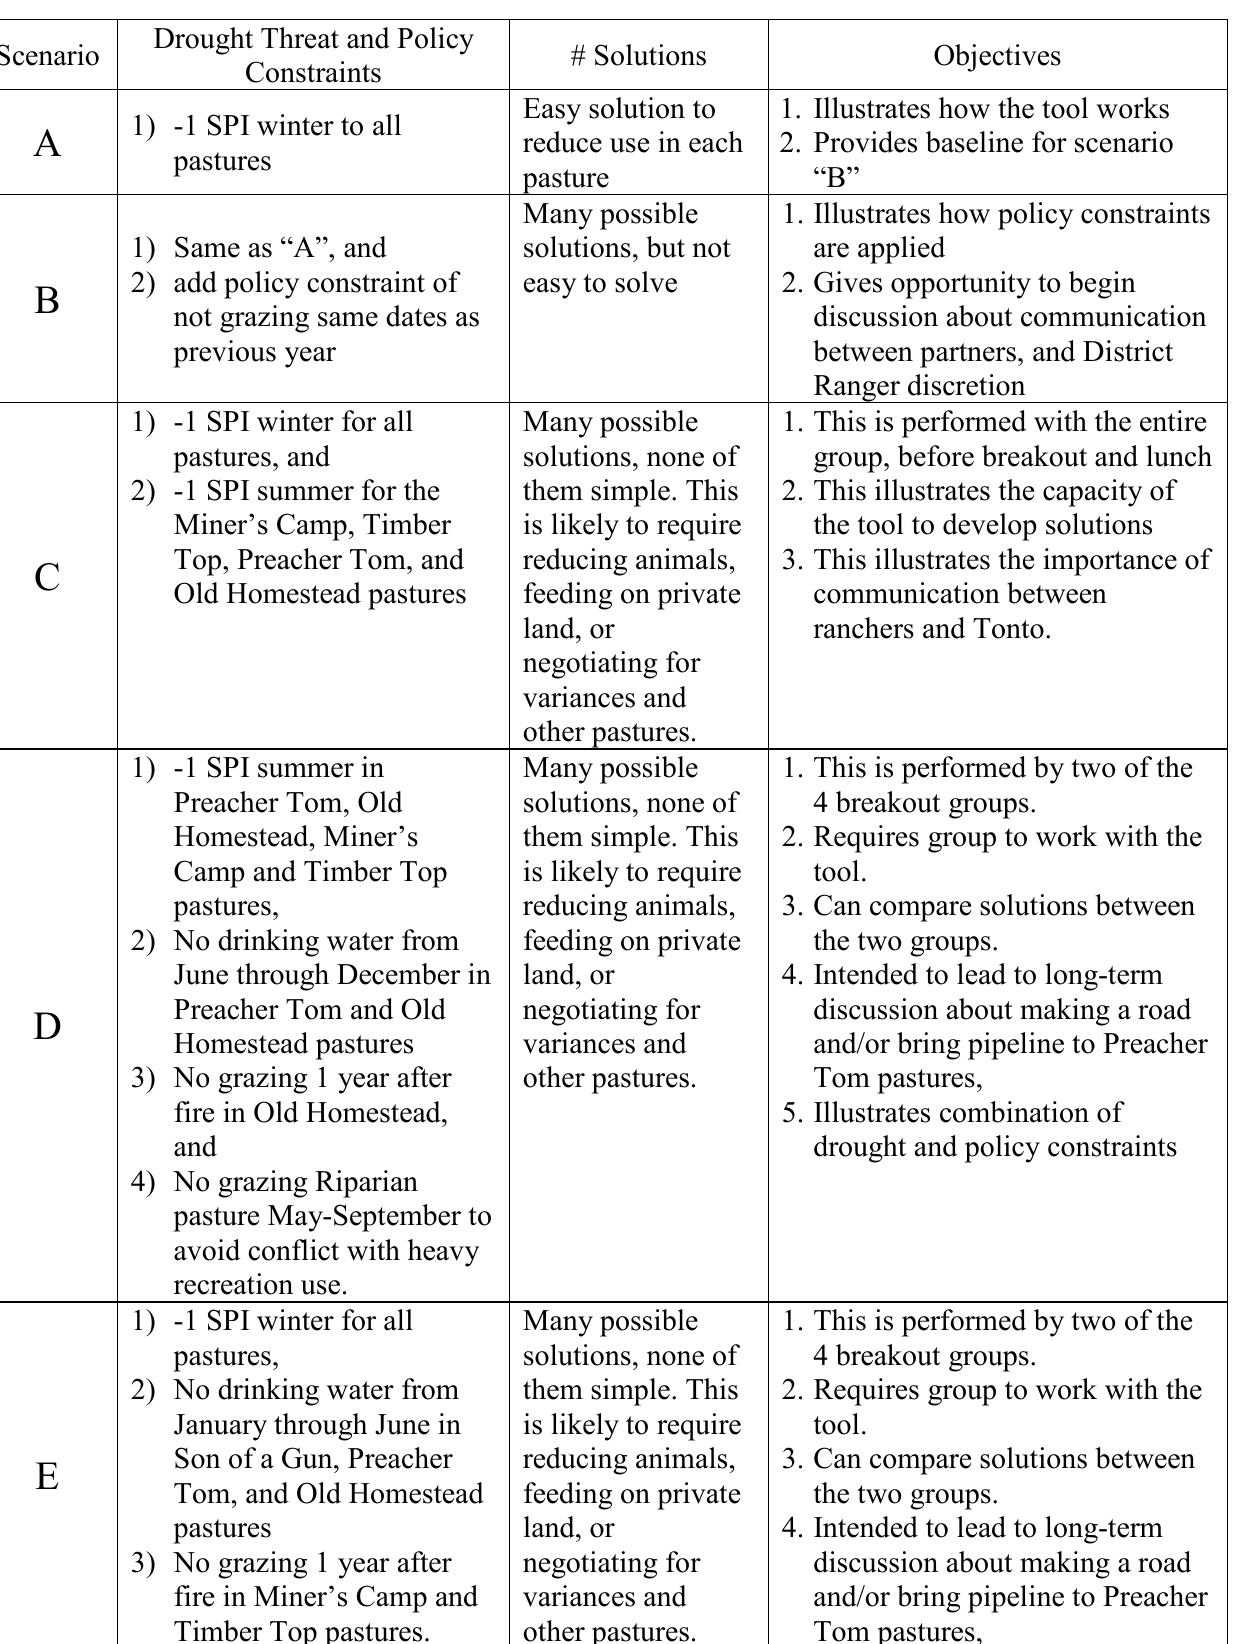
Table A1.1: Drought scenarios used for group exercises _____________________________________________________________________________ Drought Threat and Scenario